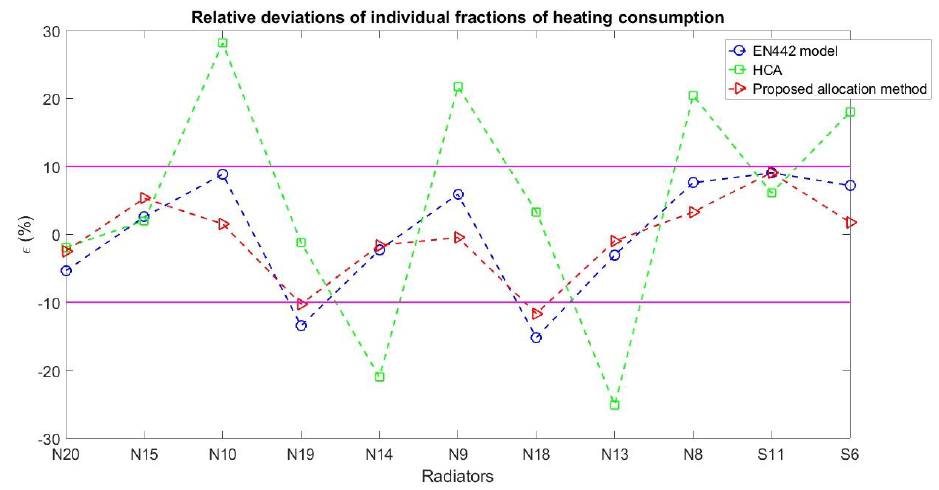
Figure 10. Relative deviations from reference measurements of individual fractions of heating consumption.